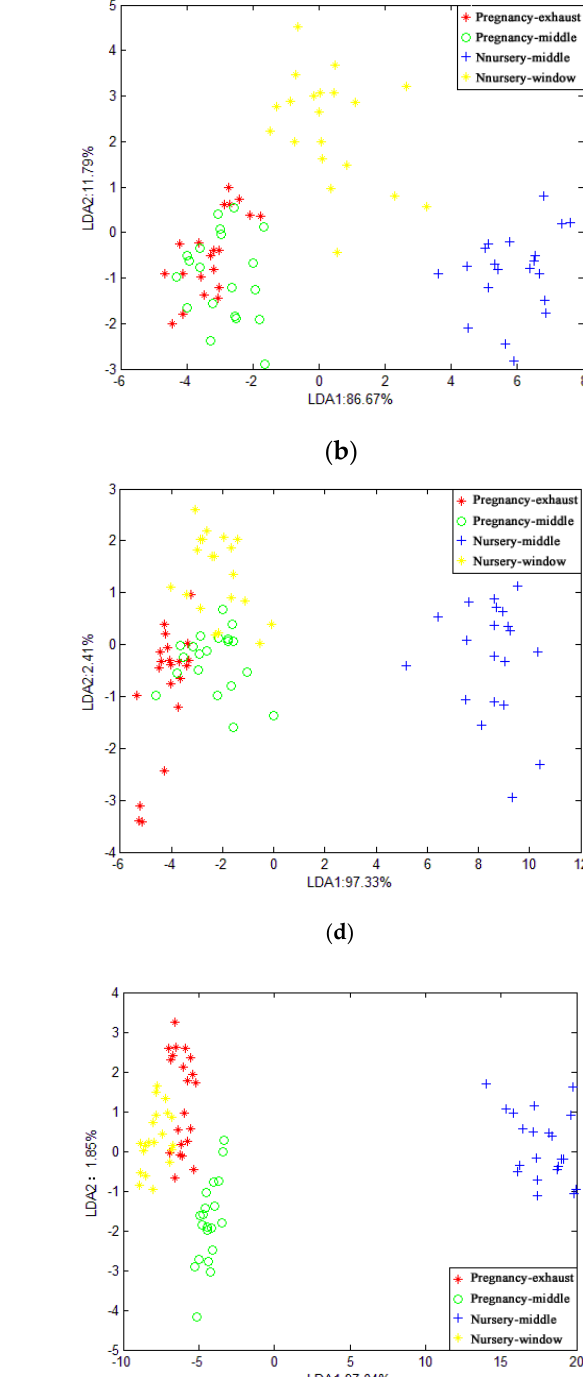
( d ) Figure 6. LDA chart of different times at the same position in the pig house with features of maximum values: ( a ) preg- nancy-exhaust; ( b ) pregnancy-middle; ( c ) nursery-middle; ( d ) nursery-window.